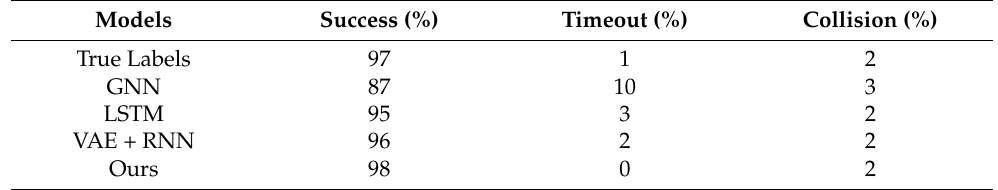
Table 3. Objective evaluation decision results of self-driving strategies with aggressive drivers p = 0.6.